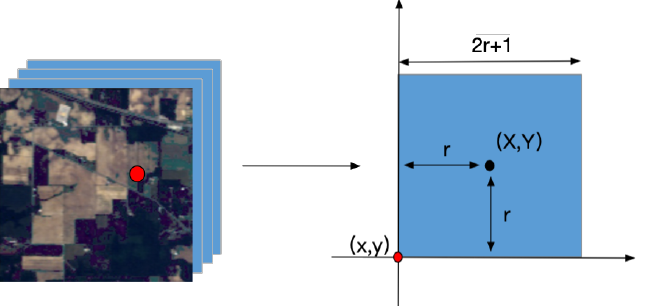
Figure 2. Window definition for a single pixel. Specify ( x , y ) as the coordinates of the target pixel (red point), and ( X , Y ) as the centre coordinates of the side window. First, the coordinates of the centre pixel are calculated from the coordinates of the target pixels. The illustrated example is ( X , Y ) = ( x + r , y + r ) . The calculation formula of the centre position ( X , Y ) coordinates of different side windows is different. Then, the shape of the side window is delineated by the central pixel, the horizontal range is from X − r to X + r , and the vertical direction is from Y − r to Y + r . This results in a rectangular side window.